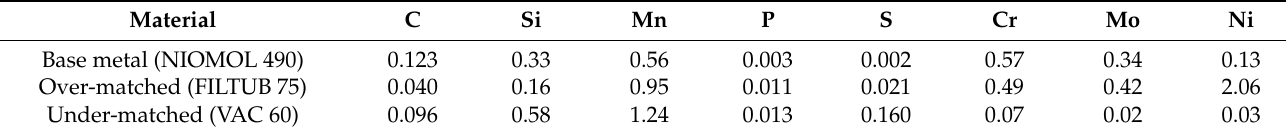
Table 2. Chemical composition of base and weld